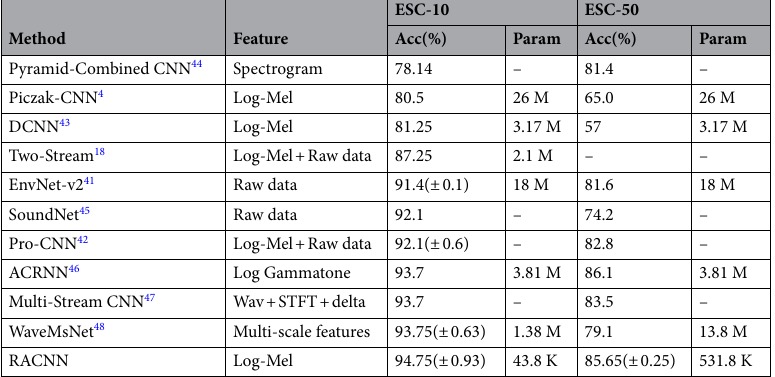
Table 6. Comparison of RACNN and state-of-the-art methods on ESC-10 and ESC-50